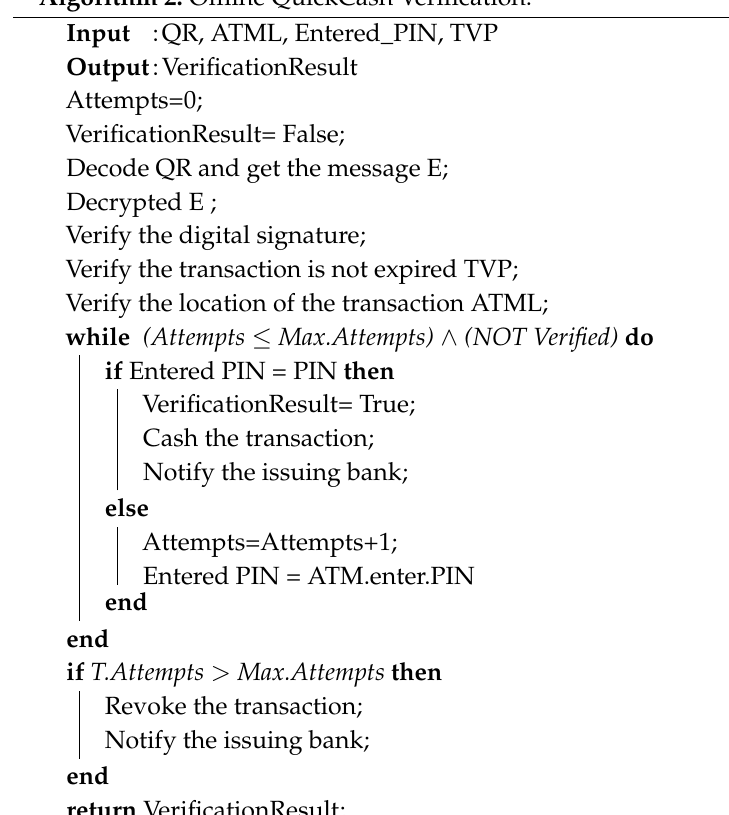
Algorithm 2: Offline QuickCash Verification.